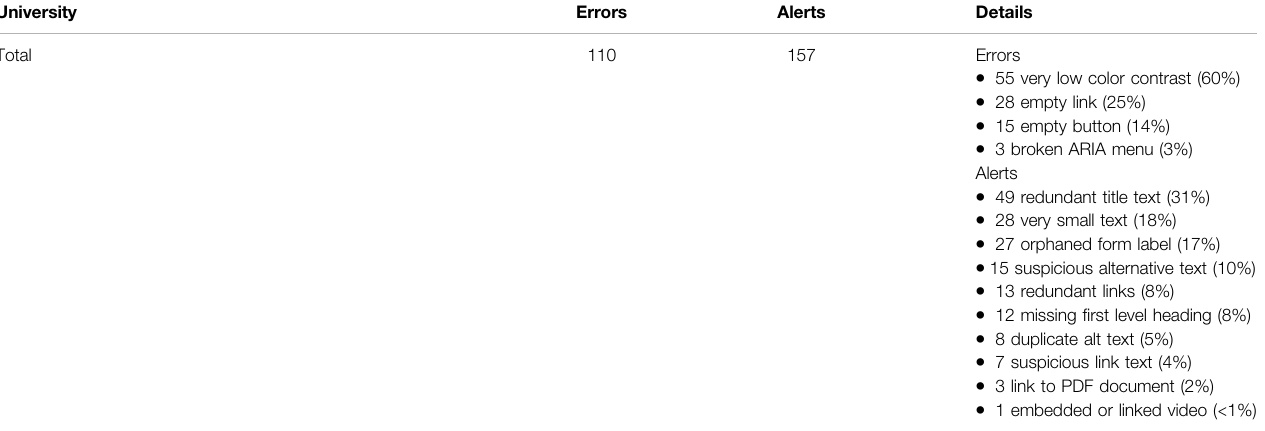
TABLE 4 | ( Continued ) Summary accessibility evaluation results for university VLEs from WAVE accessibility evaluation